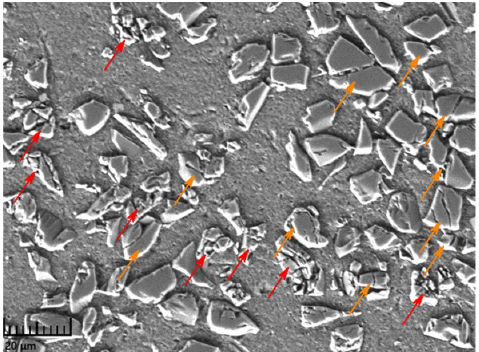
Figure 9. Particle failure mode in a specimen (yellow arrows: cracked particles; red arrows: smashed